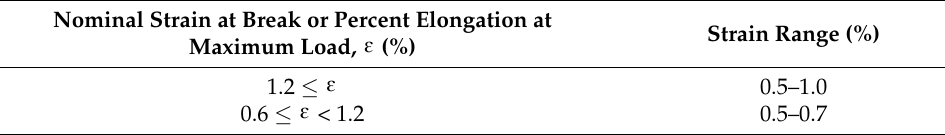
Table 1. Strain ranges used for determination of tensile modulus. Nominal Strain at Break or Percent Elongation at Maximum Load, ɛ (%)